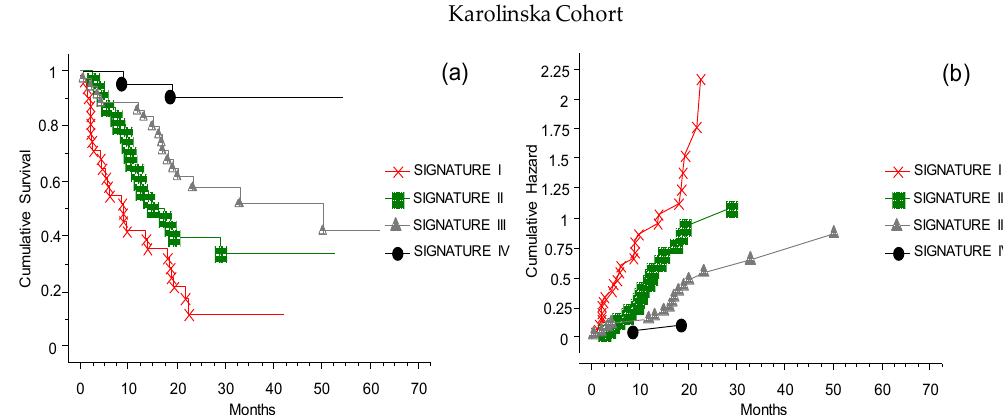
Figure 10. The CLICAL signatures obtained from the external cohort from Karolinska. Due to the restricted numbers, the cases could only be grouped in Signatures I–IV. ( a ) The plot shows the cumulative survival, with the distribution of the patients grouped by their signatures. The four curves are significantly separated from one another ( p = 0.001). ( b ) The presentation of the cumulative risks for each signature easily shows that the CLICAL can determine the characteristics of each signature.